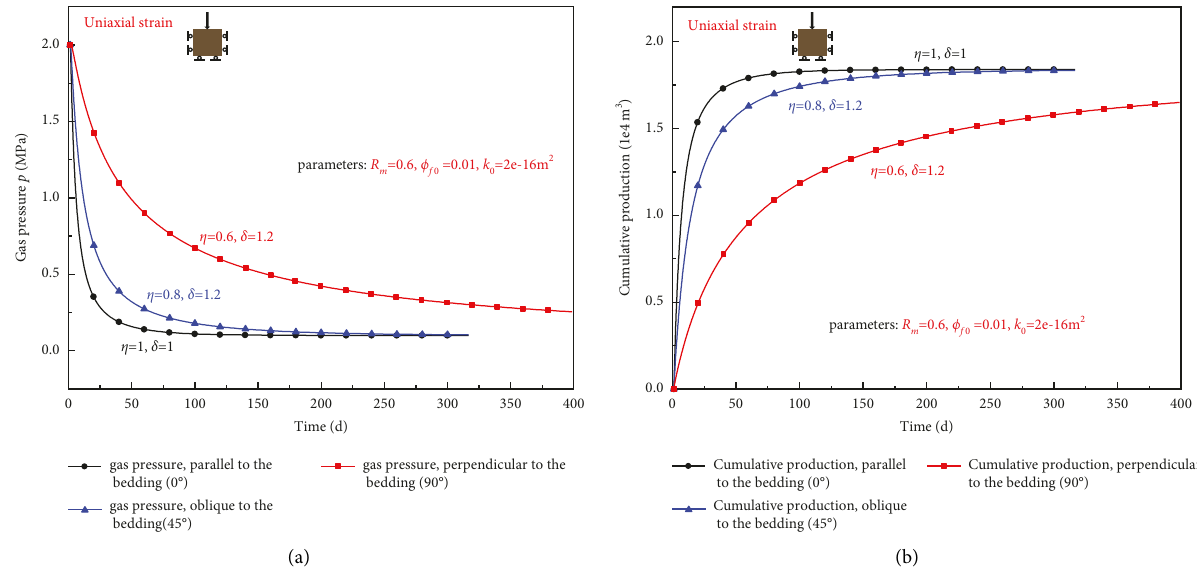
Figure 12: (a) Gas pressure and (b) cumulative production forecast as a function of time under uniaxial strain condition.